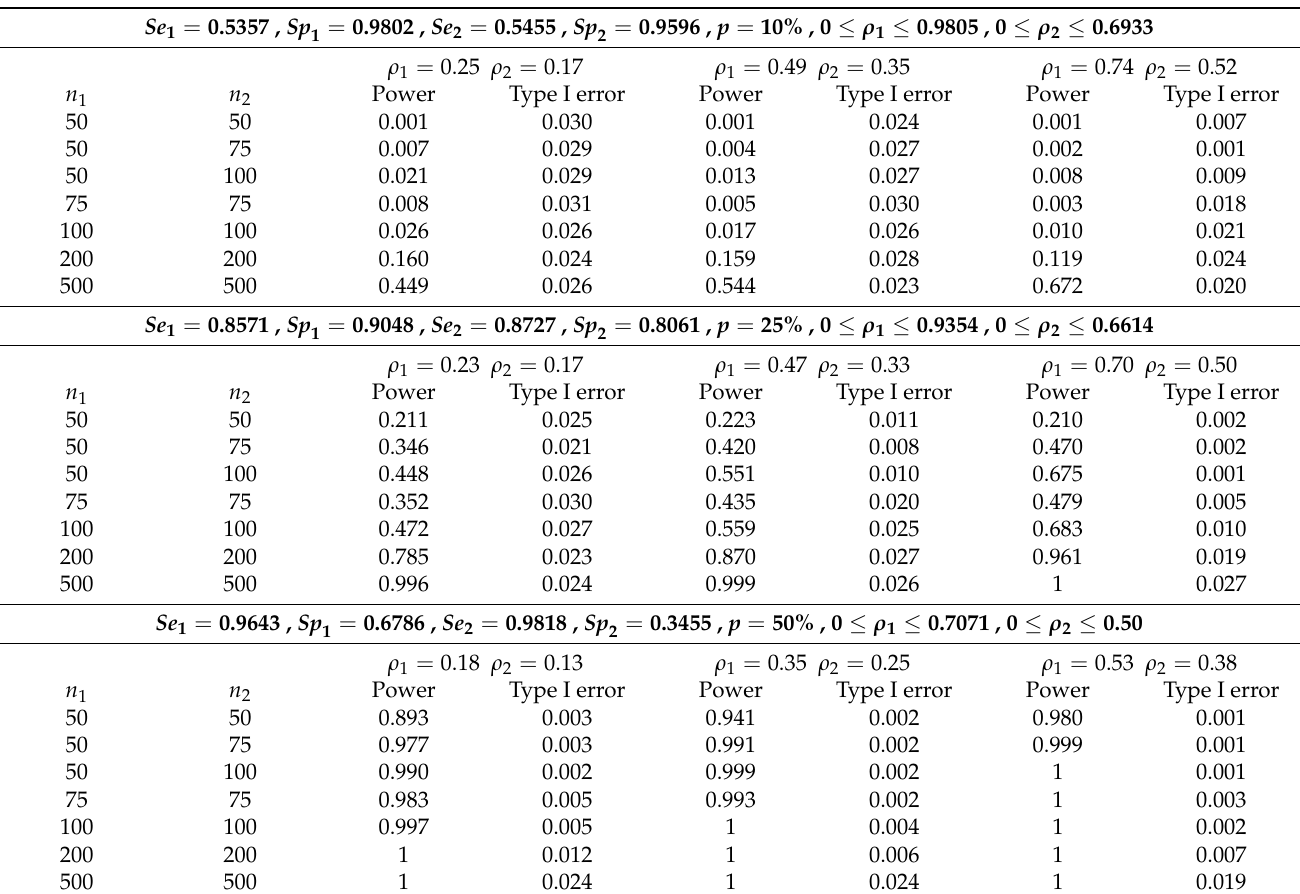
Table 6. Power of the test H 0 : PPV 1 = PPV 2 and type I error of the test H 0 : NPV 1 = NPV 2 when PPV 1 = 0.75, NPV 1 = 0.95, PPV 2 = 0.60 and NPV 2 =